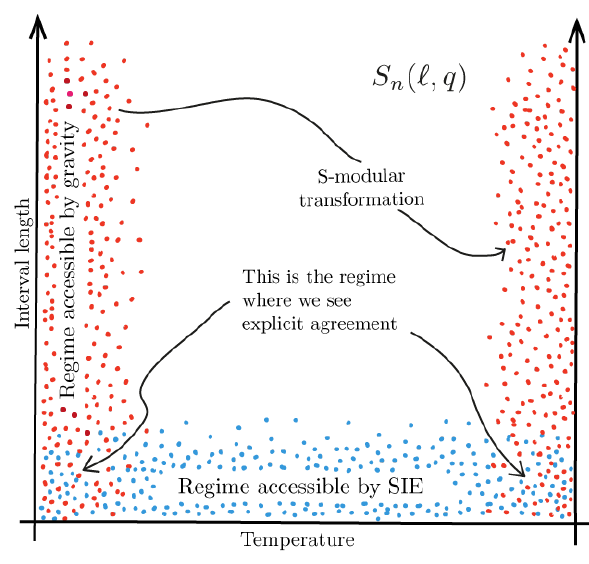
Figure 1 . Illustrating the accessible regimes of CFT and holographic calculations. The short interval expansion (SIE) is non-perturbative in q (the nome) at each order in the interval length. On the other hand, the holographic calculation provides the q -expansion and is non-perturbative in the interval length at each order in q